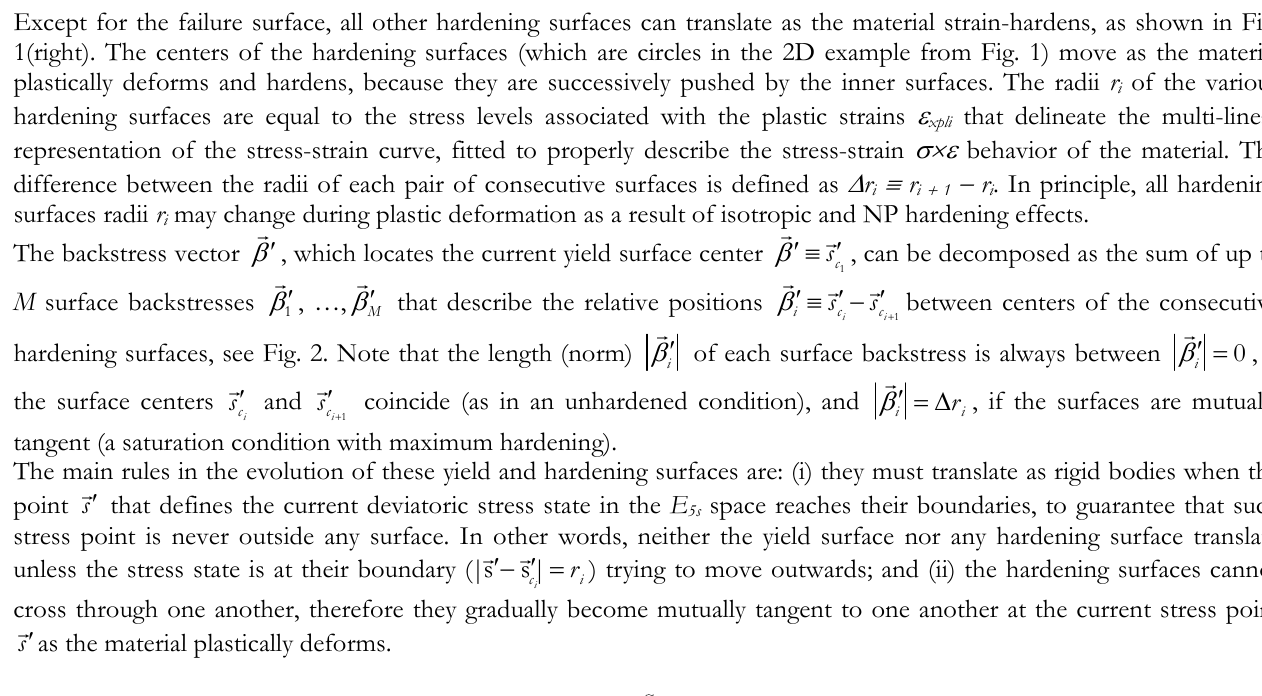
Figure 2: Yield, hardening, and failure surfaces in the deviatoric space for M  3 , showing the backstress vector  location of the yield surface